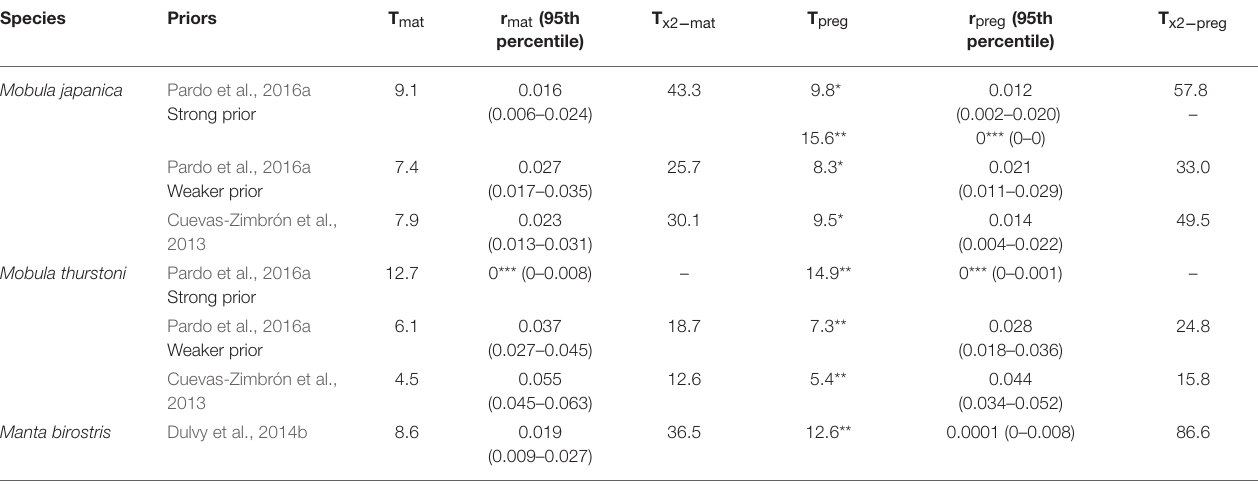
TABLE 6 | Intrinsic population growth rate and population doubling time relating to the age-at-maturity and -at-pregnancy for M. japanica , M. thurstoni, and M. birostris . Species Priors T